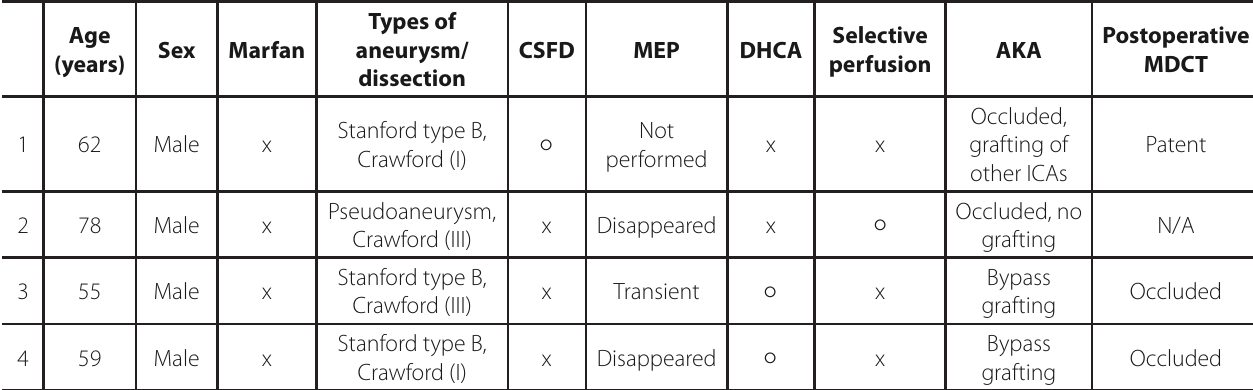
Table 4. Details of paraplegia in